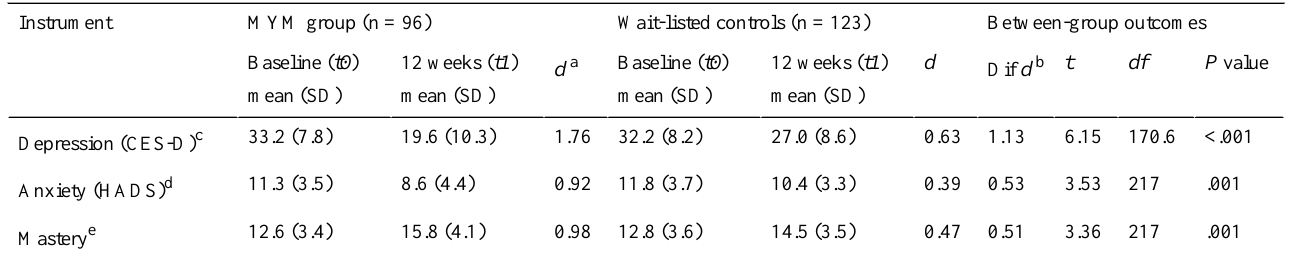
Table 5. Effects of Master Your Mood (MYM) course: MYM participants attending at least one session compared with wait-listed control group, expectation-maximization imputation.